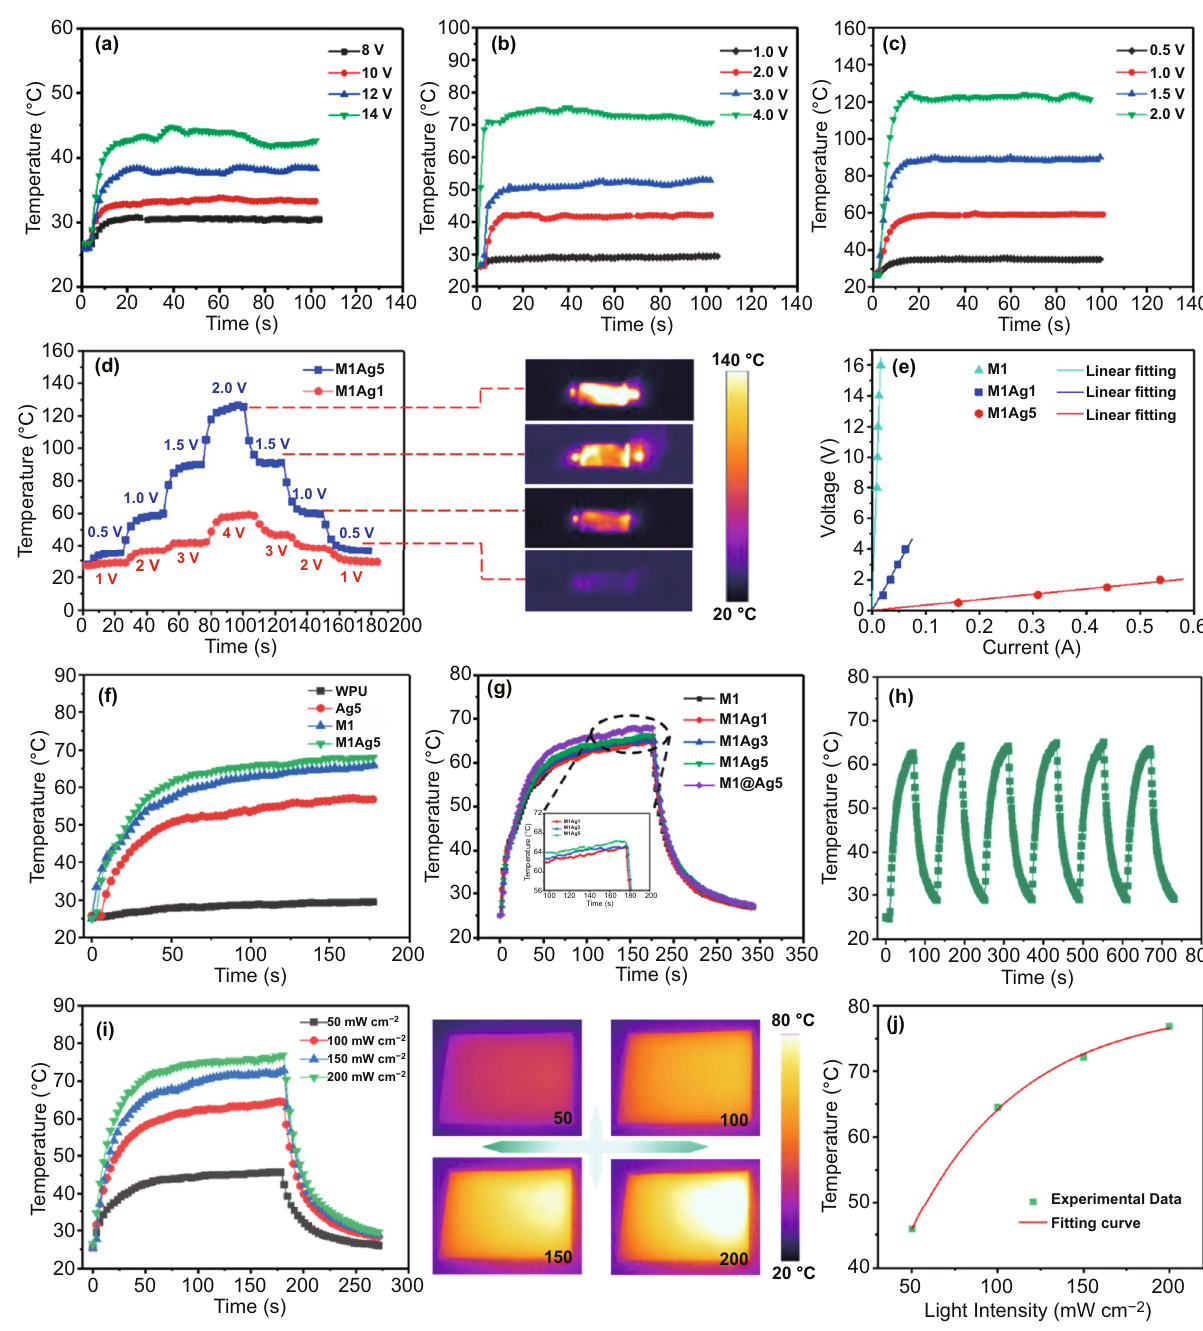
Fig. 2 Temperature variation at different applied voltages of a M1, b M1Ag1, c M1Ag5 EHFs. d Temperature evolution of M1Ag1 and M1Ag5 upon gradient changed voltages. e Voltage–current curves. f, g Temperature of different films under 100 mW cm −2 . h Temperature variation curve under cycles of on−off light illumination. i Temperature difference of M1A5 film under different irradiated power densities. j Experimen- tal data and fitting curve of peak temperature versus the irradiated power